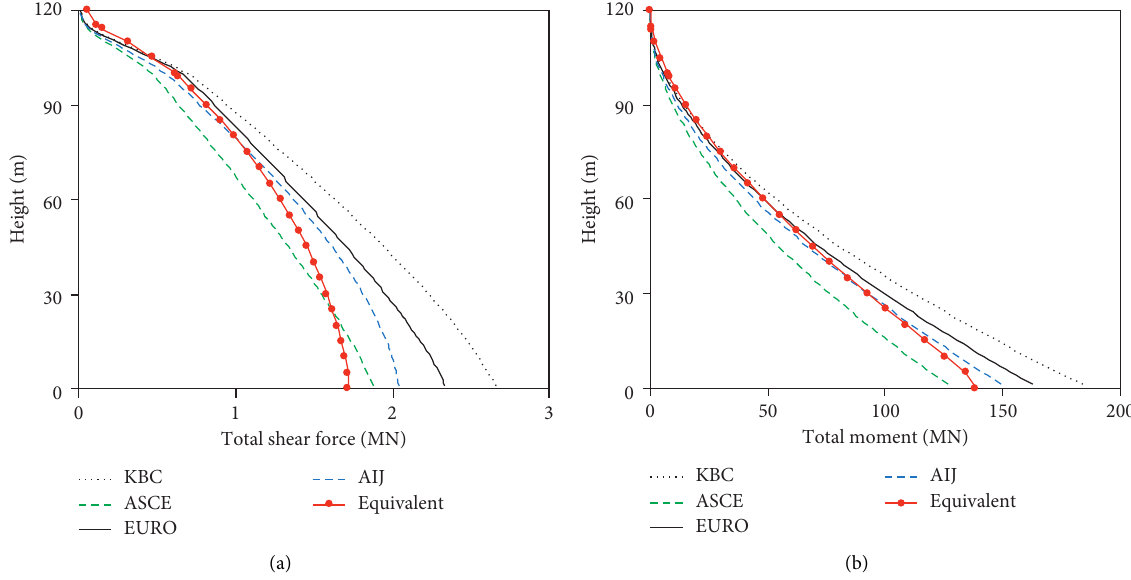
Figure 16: Along-wind shear forces and moments evaluated using design codes and aeroelastic test-based equivalent approach. (a) Shear force. (b) Moment.